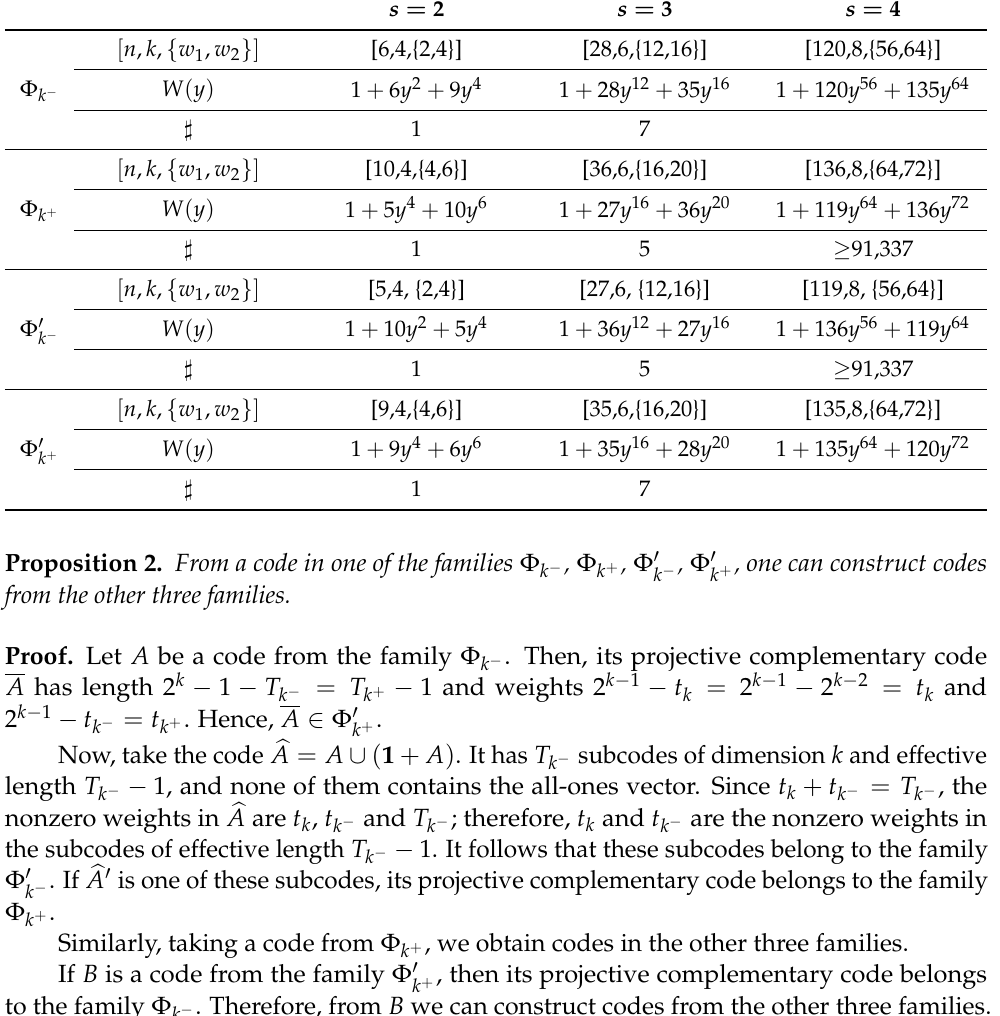
Table 1. Families Φ k ± and Φ (cid:48)